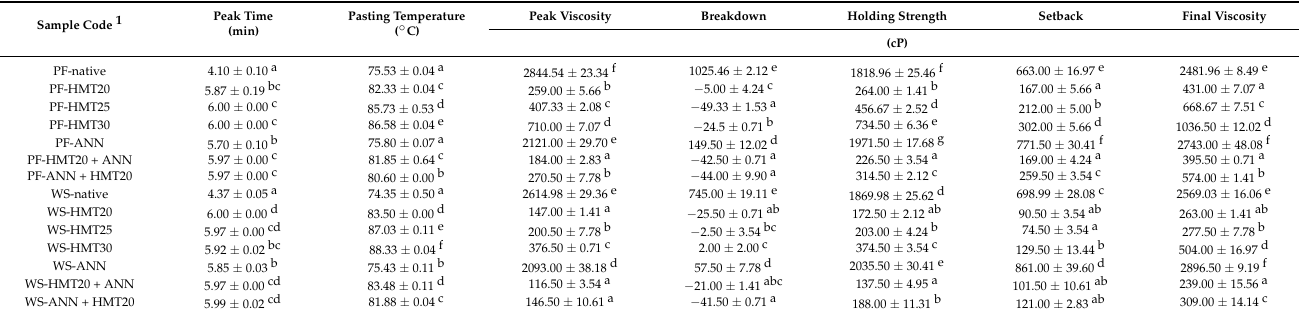
Table 4. Rapid-visco parameters of native/modified lotus rhizome starches 2